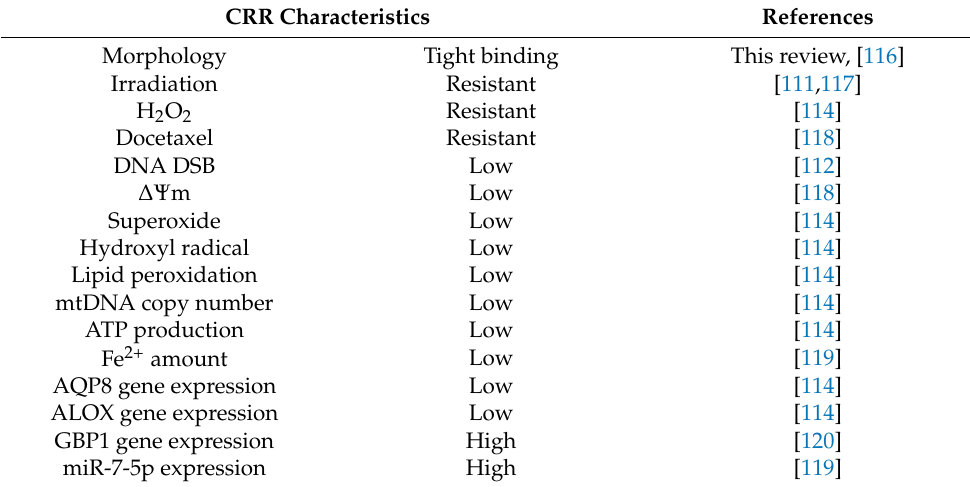
Table 2. Characteristics of clinically relevant radioresistant (CRR)